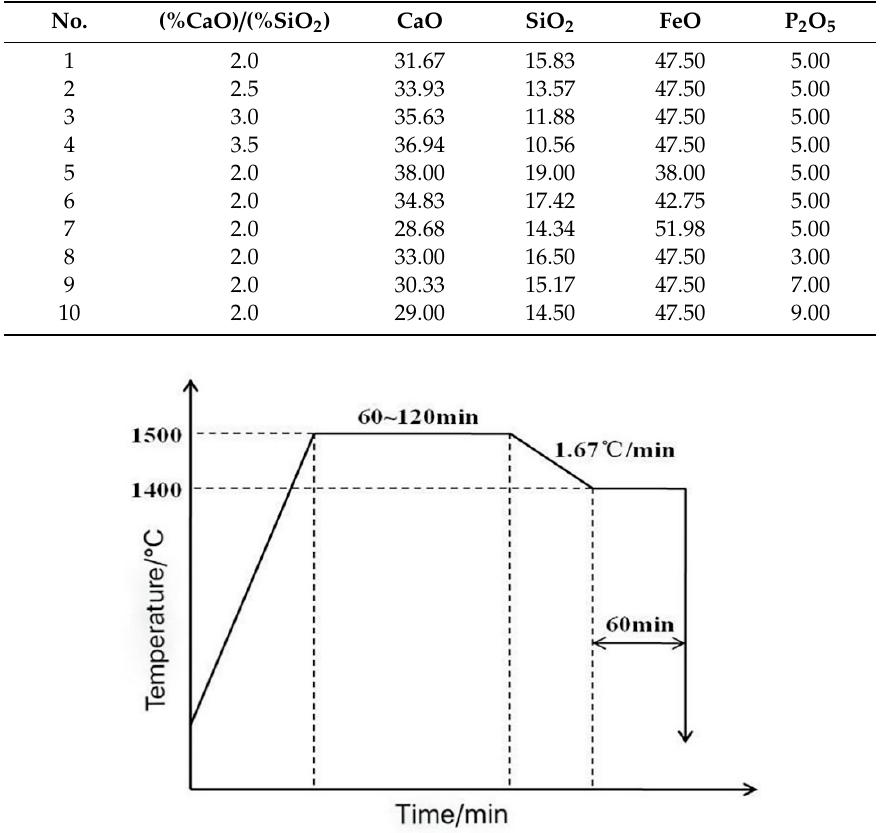
Table 1. Composition of the slag samples / wt %.